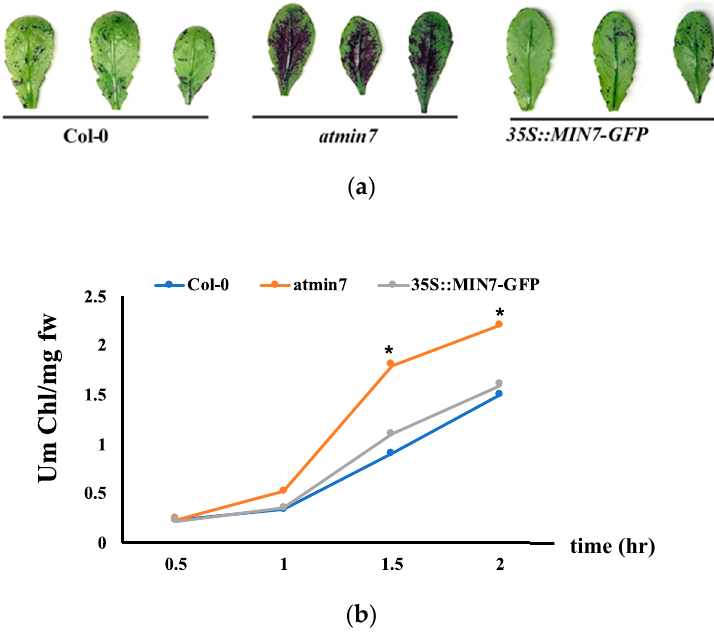
Figure 2. AtMIN7 is required for the normal cuticle formation. ( a ). Leaves of four-week-old WT Col-0, atmin7 , and 35S::MIN7-GFP complementation plants stained with TB. The mutant atmin7 plants showed the TB staining but not the WT and 35S::MIN7-GFP complementation plants, which indicated the defective cuticle in atmin7 mutant plants. ( b ). Chlorophyll leaching rate of the leaves of WT (blue circles), atmin7 (orange circles), and 35S::MIN7-GFP (grey circles) plants. The experiment was repeated three times with the similar results and mean +/- SD for the combined data from three replicates are shown. Unpaired two-tailed Student’s t -tests with WT plants indicated that chlorophyll leaching did not differ from 35S::MIN7-GFP but was significantly increased at 1.5 and 2 h in atmin7 plants (* p < 0.05), which indicated the defective cuticle in the atmin7 mutant plants.